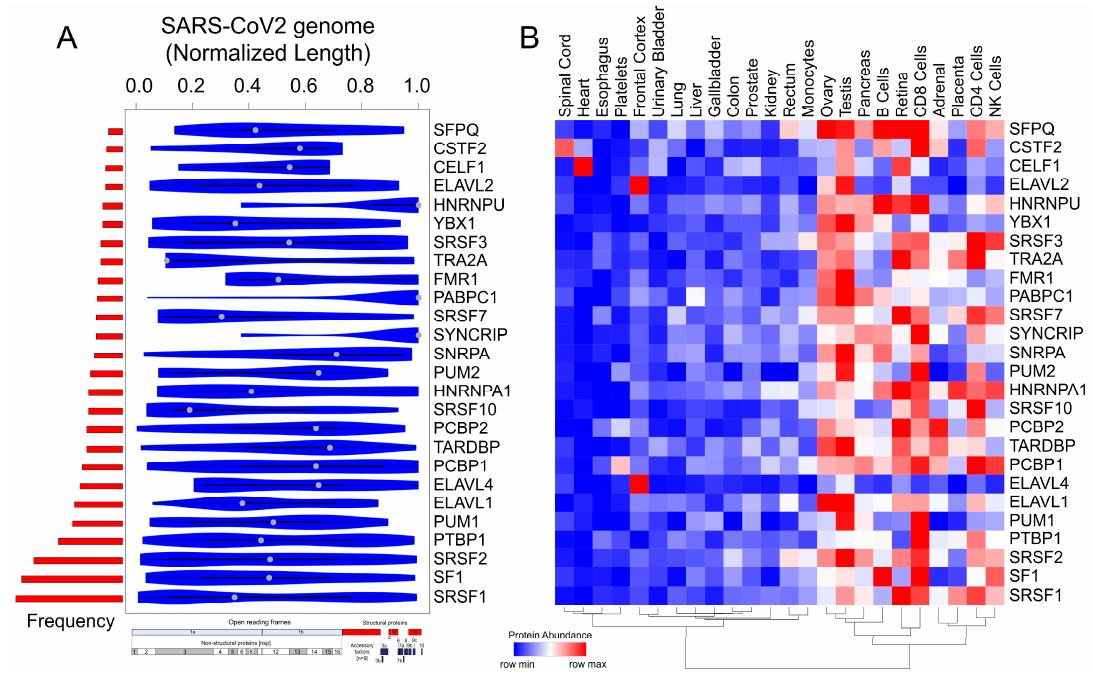
Figure 4. Motif enrichment analysis reveals potential human RBPs titrated by the SARS ‐ CoV ‐ 2 viral genome. ( A ) Violin plot shows the statistically significant ( p < 1 × 10 − 5 ) preferential binding profile of the RBP motifs (sorted by frequency of binding and greater than 10 sites) across the SARS ‐ CoV ‐ 2 viral genome (length normalized) identified using FIMO. ( B ) Hierarchically clustered heatmap showing the protein abundance (row normalized) of RBPs across tissues.